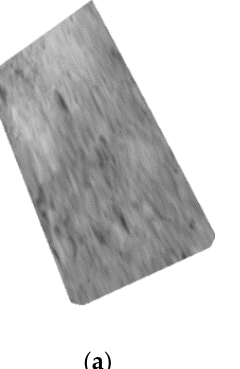
Figure 21. Orthorectified images of ROI 2 in Yutu-2 rover imagery ( a ) ROI 2 of 94741, ( b ) ROI 2 of 94914, ( c ) ROI 2 of 95633.